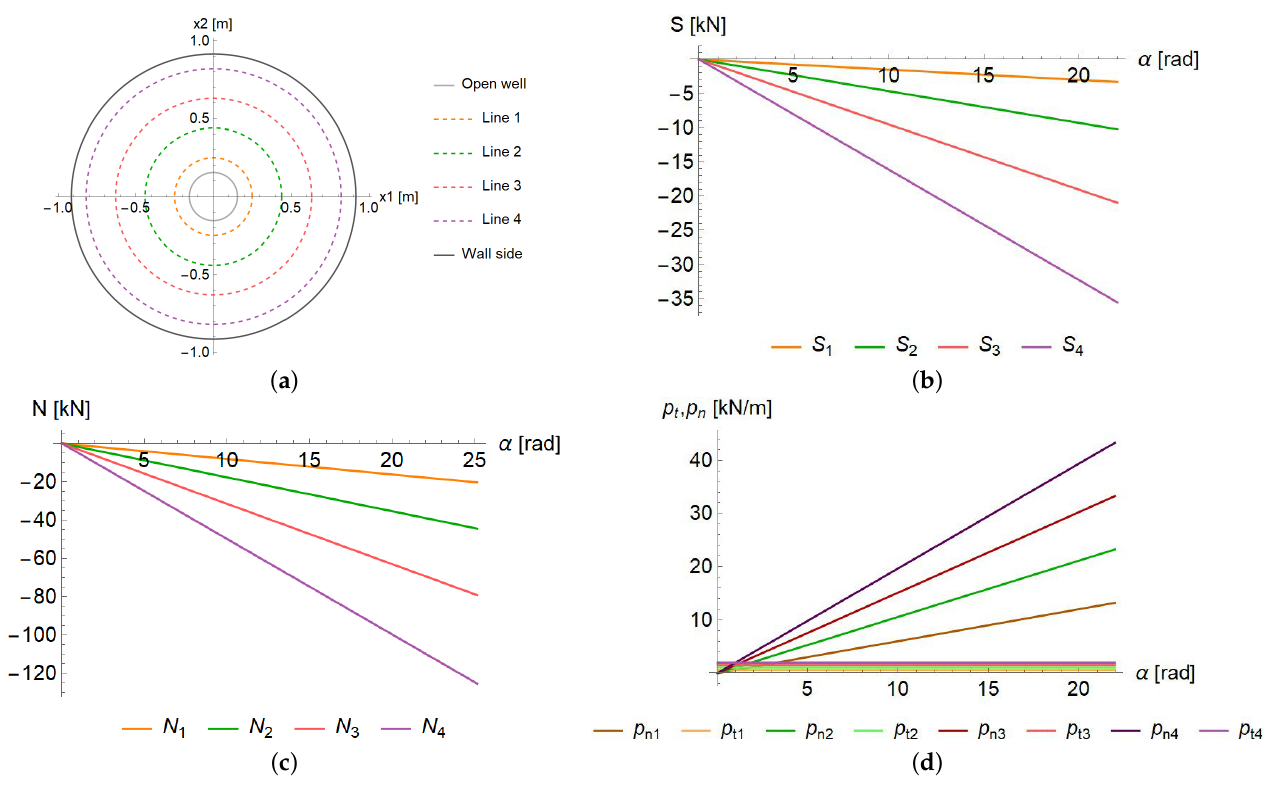
Figure 6. ( a ) Projected stair and line geometry for the spiral stair of Nisida; Plots of ( b ) thrust S i ( α ) , ( c ) normal force N i ( α ) , ( d ) tangential p ti ( α ) and normal p ni ( α ) components of the